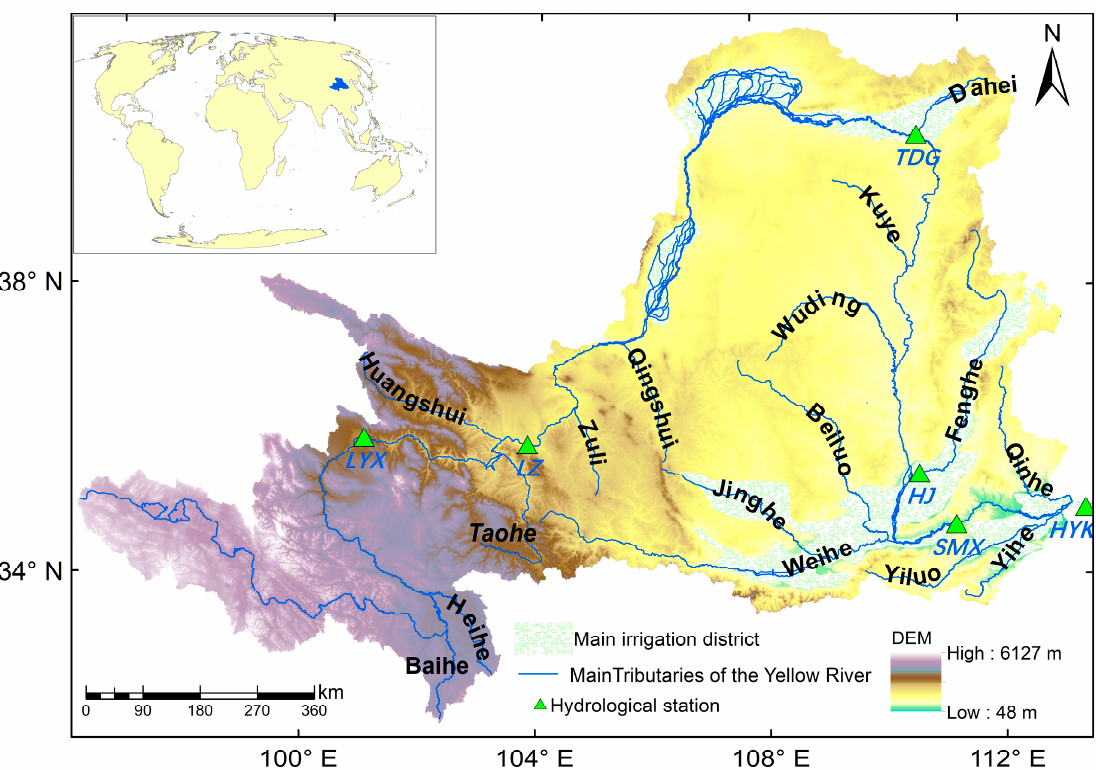
Figure 1. The location and elevation as well as the distribution of the main tributaries and irrigation areas of the study area. The green triangles represent the location of hydrological sites. LYX is Langyagnxia station; LZ is Lanzhou station; TDG is Toudaogui station; HJ is Hejin station; SMX is Sanmenxia station; HYK is Huayuankou station; HID is Hetao Irrigation District; and YID is Yinchuan Irrigation